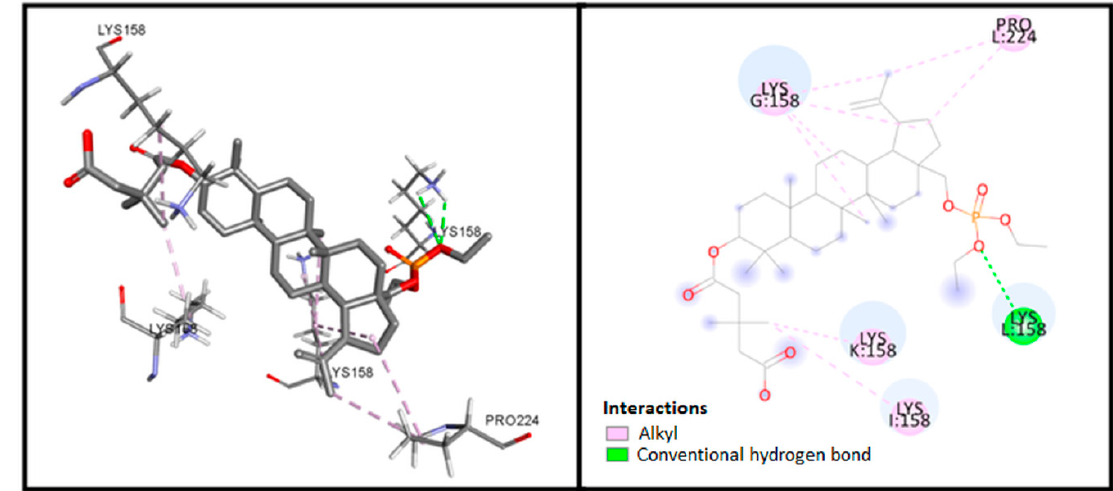
Figure 4. Visualization of interactions between compound 4 and CA-CTD-SP1.